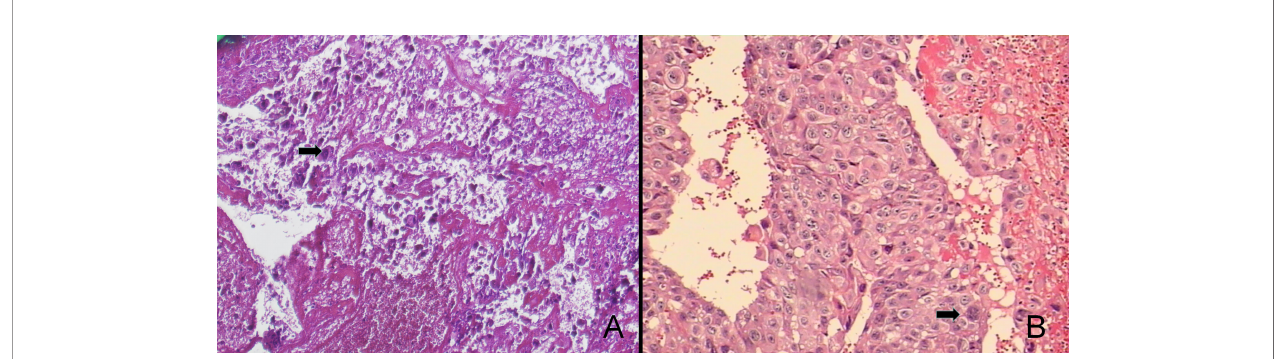
FIGURE 1 | The pathological fi ndings were choriocarcinoma accompanied with extensive hemorrhage and necrosis (100×, A ). The tumor consists of syncytiotrophoblastic cells and cytotrophoblastic cells, which were characterized as medium-sized, whereas the peripheral one was composed of large, multinucleated cells (200×, B ).